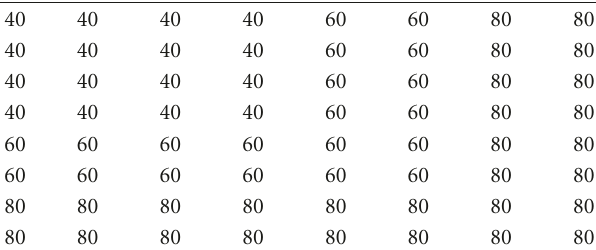
Figure 2: PSNR versus bit-rate for the Barbara image of size 512 × 512 for various quantization approaches. Table 2: Proposed quantization table for the luminance